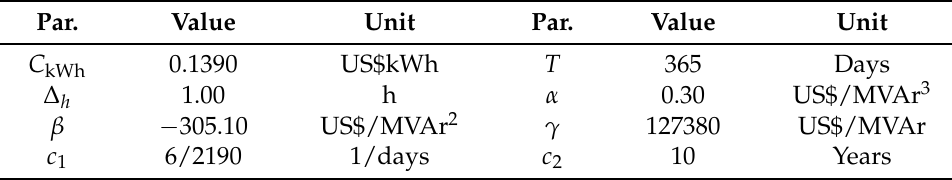
Table 3. Parameters associated with the objective function calculation.